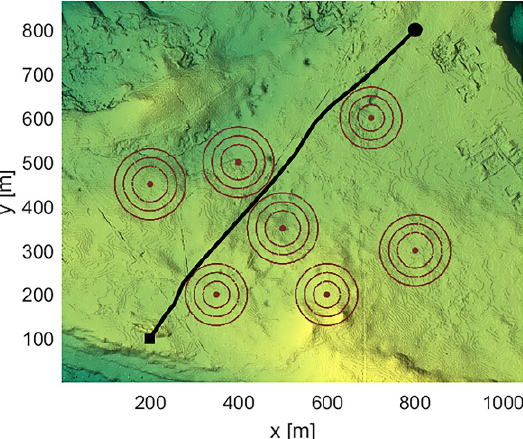
Figure 21. The top view of the path generated by the ninth group of data for the PSO algorithm.